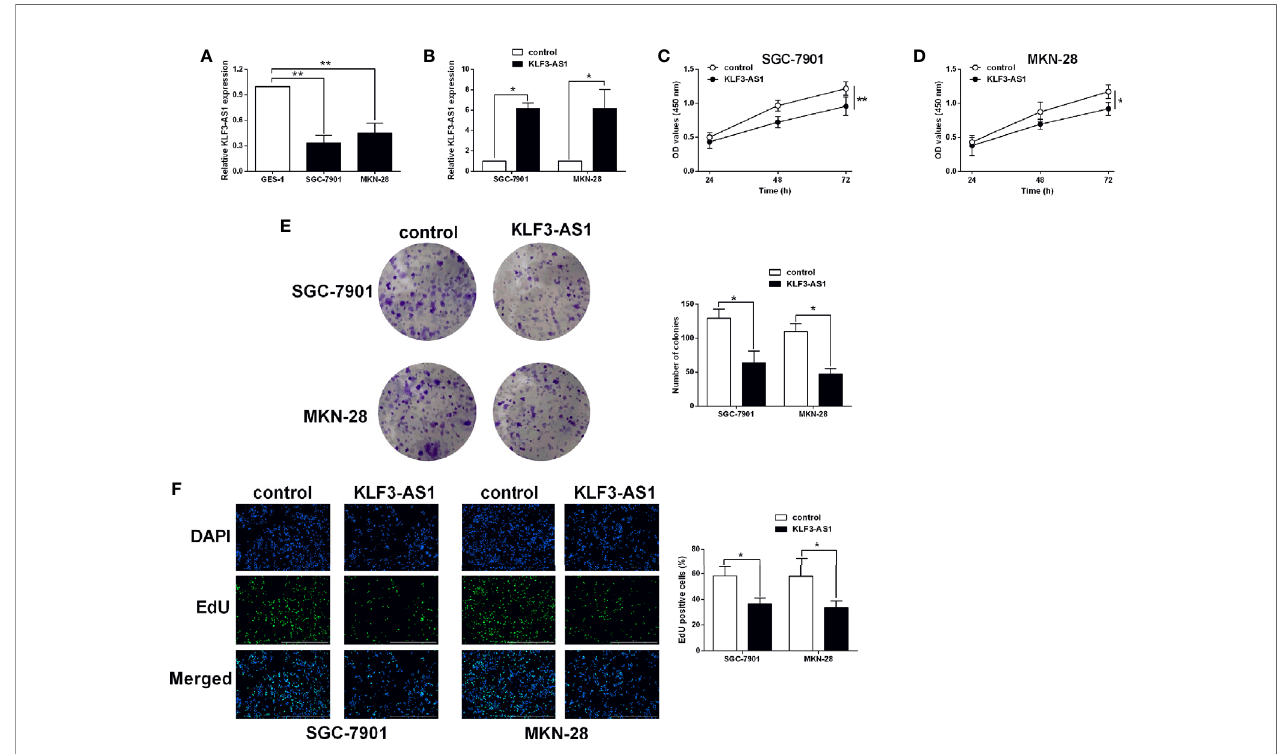
FIGURE 1 | KLF3-AS1 overexpression suppressed gastric cancer cell viability and proliferation. (A) The expression levels of KLF3-AS1 in the GES-1, SGC-7901 and MKN-28 cells were examined by qRT-PCR (one-way ANOVA followed by Bonferroni ’ s test). (B – F) The gastric cancer cells including SGC-7901 and MKN-28 were transfected with pcDNA3.1 (control group) or pcDNA3.1-KLF3-AS1 (KLF3-AS1), and at 24 h after transfection, (B) KLF3-AS1 expression levels in the gastric cancer cells were determined by qRT-PCR; (C, D) cell viability of SGC-7901 and MKN-28 cells was determined by CCK-8 assay; (E) cell growth of SGC-7901 and MKN-28 cells was determined by colony formation assay; (F) cell proliferation of SGC-7901 and MKN-28 cells was determined by EdU assay (Student ’ s t-test). N = 3; *P < 0.05 and **P <